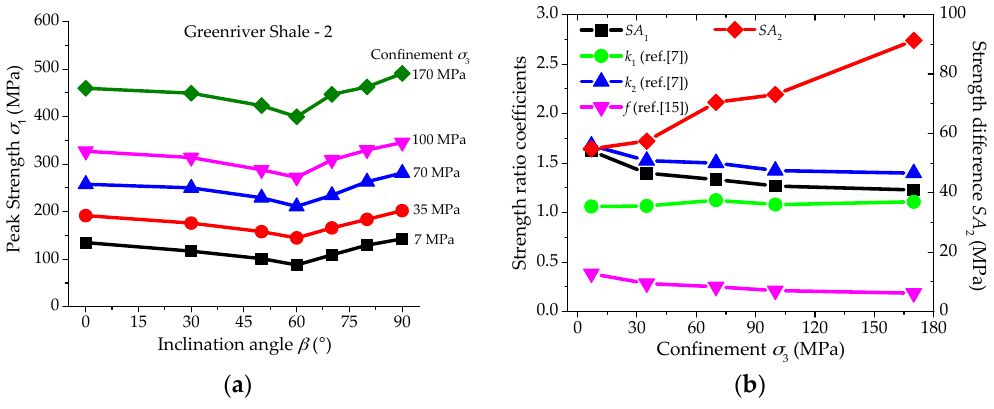
Figure 1. ( a ) Anisotropic strength values of Greenriver Shale-2 samples under various confinements [16], and ( b ) different changing trends of SA 1 , SA 2 and some other anisotropic parameters with the increasing confinement.